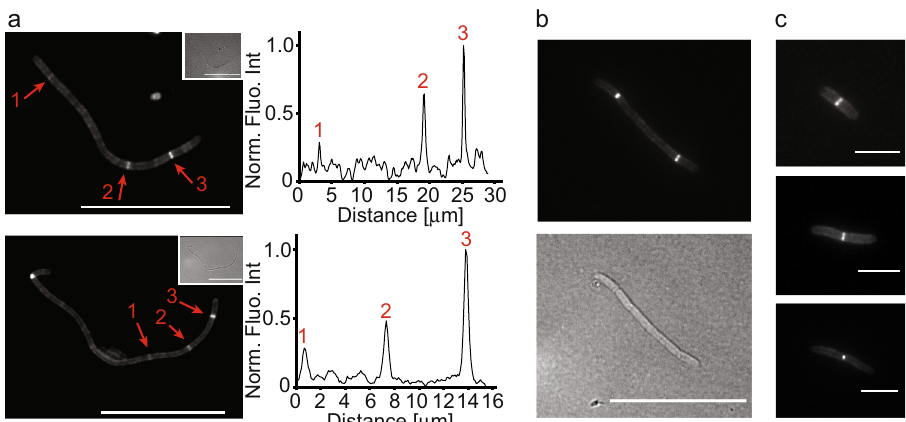
Fig. 7 Peptidoglycan synthesis is active at multiple locations at the same time. WT UTI89 fi laments from an infection cycle were labelled with the green fl uorescent D-amino acid (FDAA) probe OGDA and imaged using fl uorescence microscopy. Harvested fi laments were pelleted and resuspended in LB and placed at 37 °C for 2 h before OGDA labelling for 5 min. a Multiple active sites for peptidoglycan synthesis can be observed in fi laments. Inset: corresponding bright fi eld images. Fluorescence intensity plots for selected sections are shown next to the images (peaks numbered). b A representative mid-length fi lament with two clear OGDA accumulations at division sites. c Rod-shaped cells in various stages of membrane constriction. Cells had already reverted from fi laments and were then stained with OGDA, showing strong fl uorescence accumulation only at midcell, as expected. Scale bars a , b = 20 μ m, c = 4 μ m. Source data are provided as a Source data fi